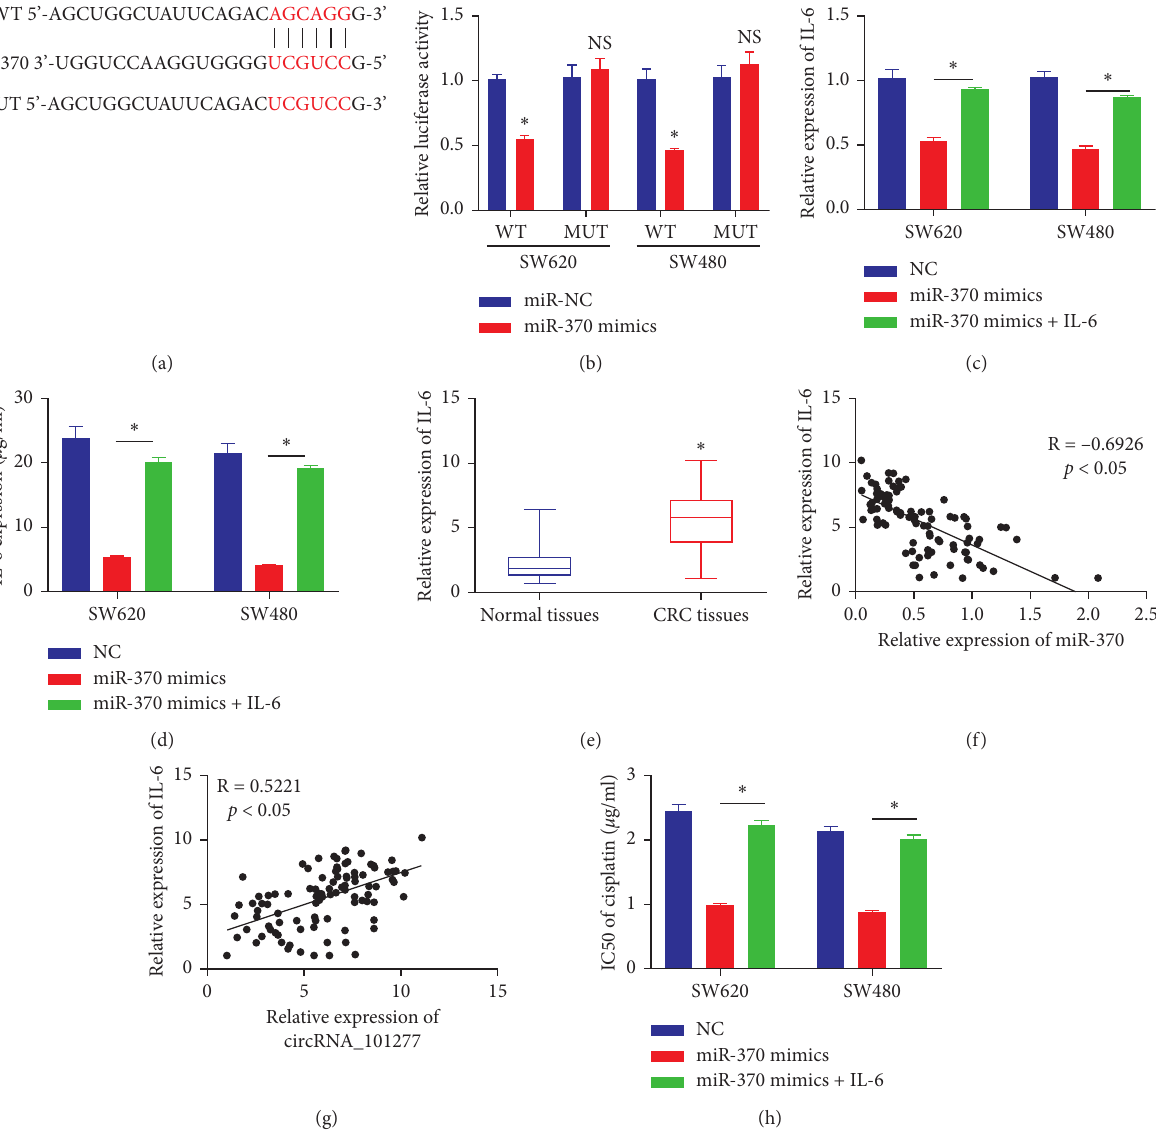
Figure 4: circRNA_101277 modulates the miR-370/IL-6 axis to enhance cisplatin resistance. (a) Putative miR-370 binding sites within the IL-6 3 ′ -UTR. (b) miR-370 mimics decreased the luciferase activity of the IL-6-WT reporter in CRC cells. The expression of IL-6 was measured via qRT-PCR (c) and ELISA (d). (e) IL-6 expression was markedly elevated in CRC tissues relative to healthy control tissue. (f) The expression of IL-6 in CRC tissues was negatively correlated with that of miR-370. (g) The expression of IL-6 was positively correlated with that of circRNA_101277 in CRC tissues. (h) An MTT assay was used to assess the cisplatin IC50 value in the indicated cells. ∗ p <